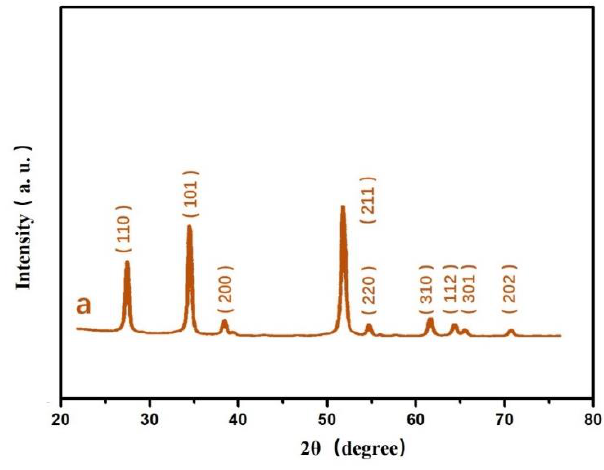
ff raction patterns of SnO Figure 2. X-ray diffraction patterns of SnO 2 . Figure 2. X-ray di Figure 2. X-ray diffraction patterns of SnO 2 .